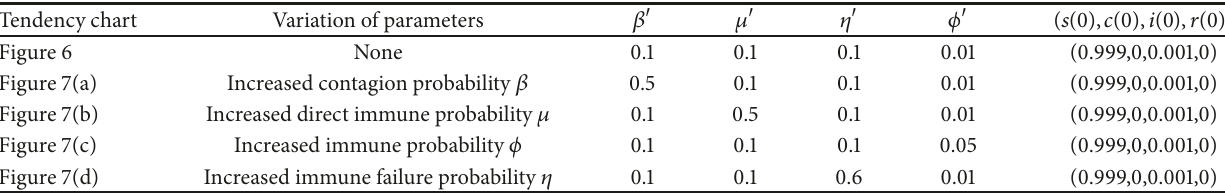
Table 3: Numerical changes of SCIR investor risk contagion model in the stockmarket underdifferent mechanism probability environments. Tendency chart